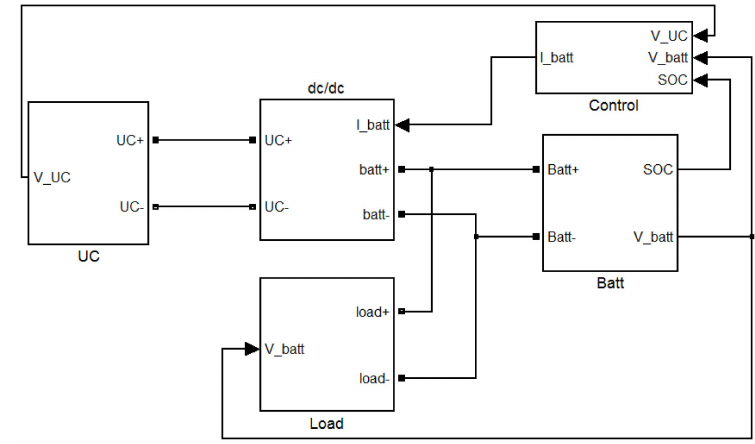
Figure 6. The HESS simulation model.